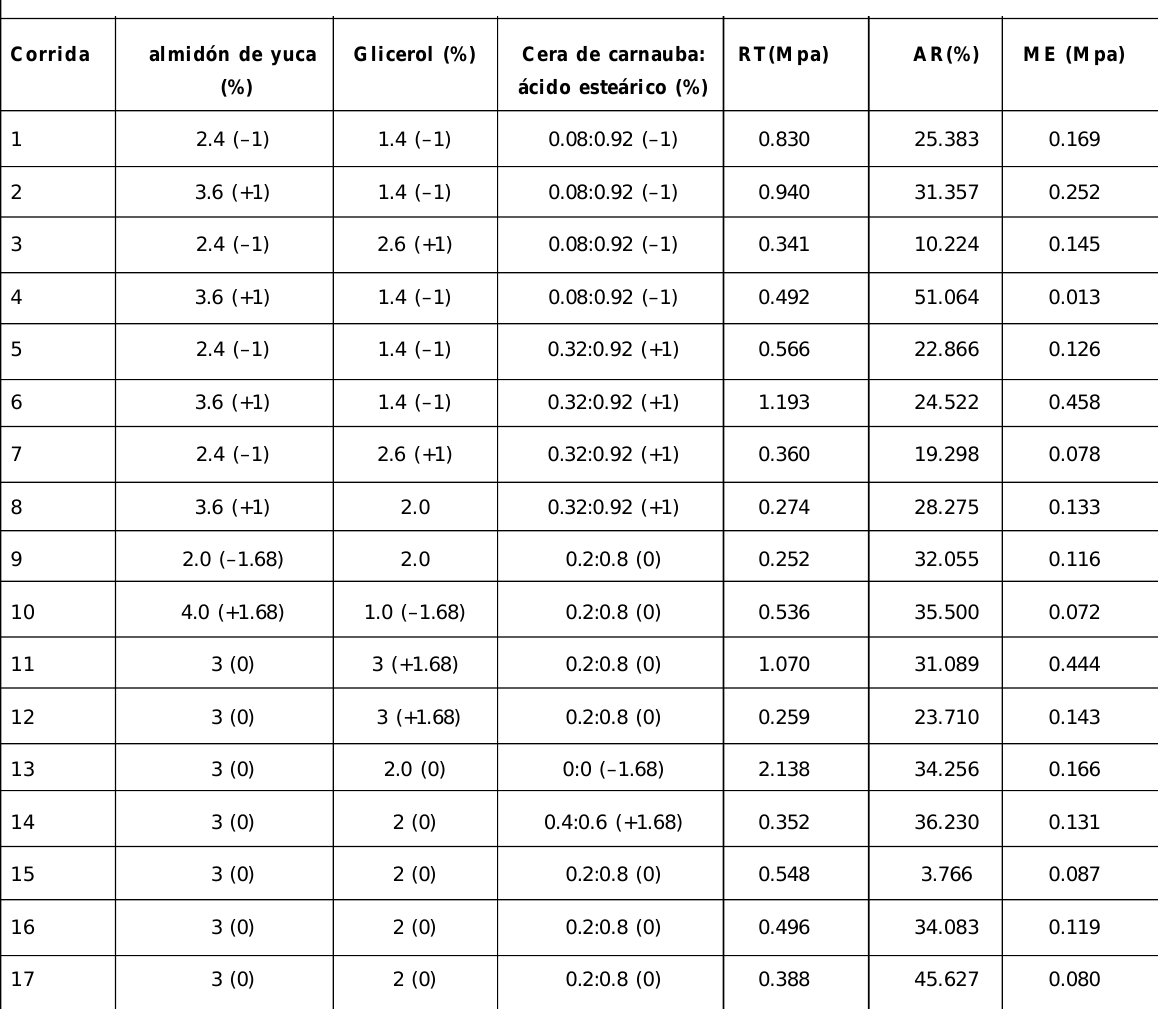
Table 4: Central composite design matrix with real and coded values (in parenthesis) of the variables and responses of mechanical properties (tensile strength - TS, elongation at break - ELO and elastic modulus - EM), edited from Chiumarelli and Hubinger, 2012 Corrida almidón de